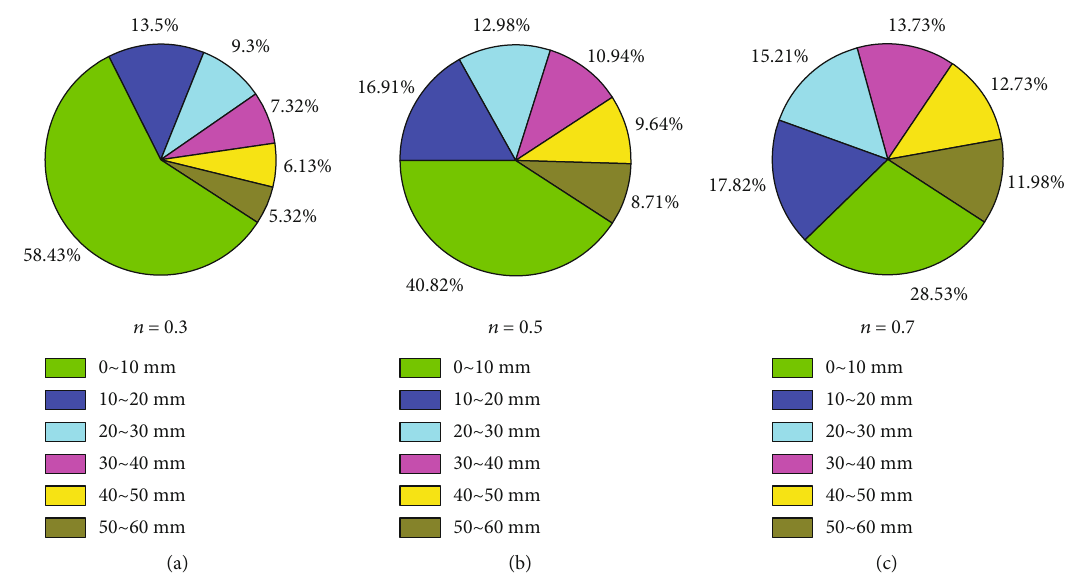
Figure 2: Grain size distribution of crushed rock for di ff erent Talbol power indices.